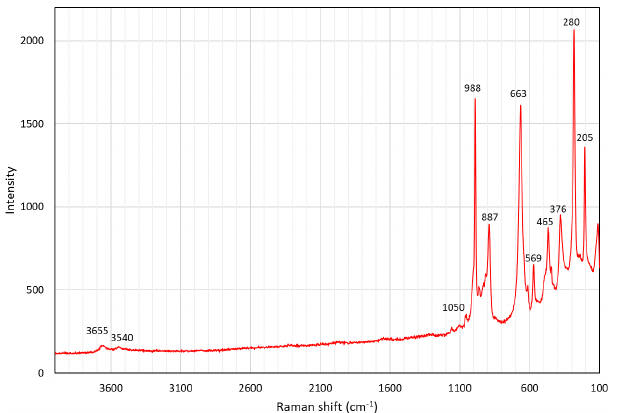
Figure 4. Raman spectrum of zinkgruvanite.